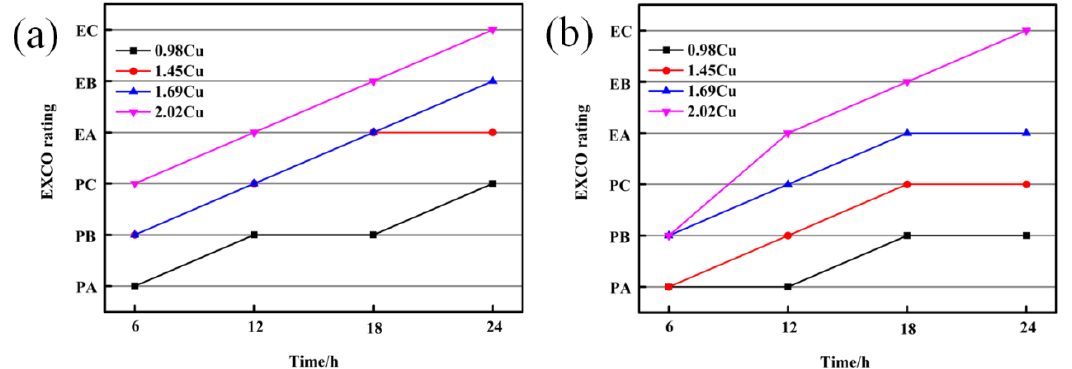
Figure 8. Variation of EXCO rating for alloys during immersing in the EXCO solution for 24 h: ( a ) L-T; ( b ) S-T.